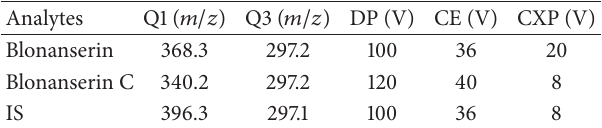
Table 1: ESI + -MS/MS parameters of the parent and daughter ions ( m/z ) and DP, CE, and CXP of blonanserin, blonanserin C, and